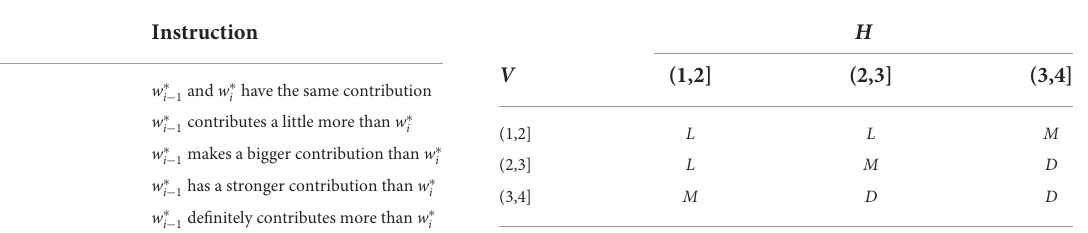
TABLE 1 Value reference for r i . TABLE 2 Epidemic risk matrix of resumption in